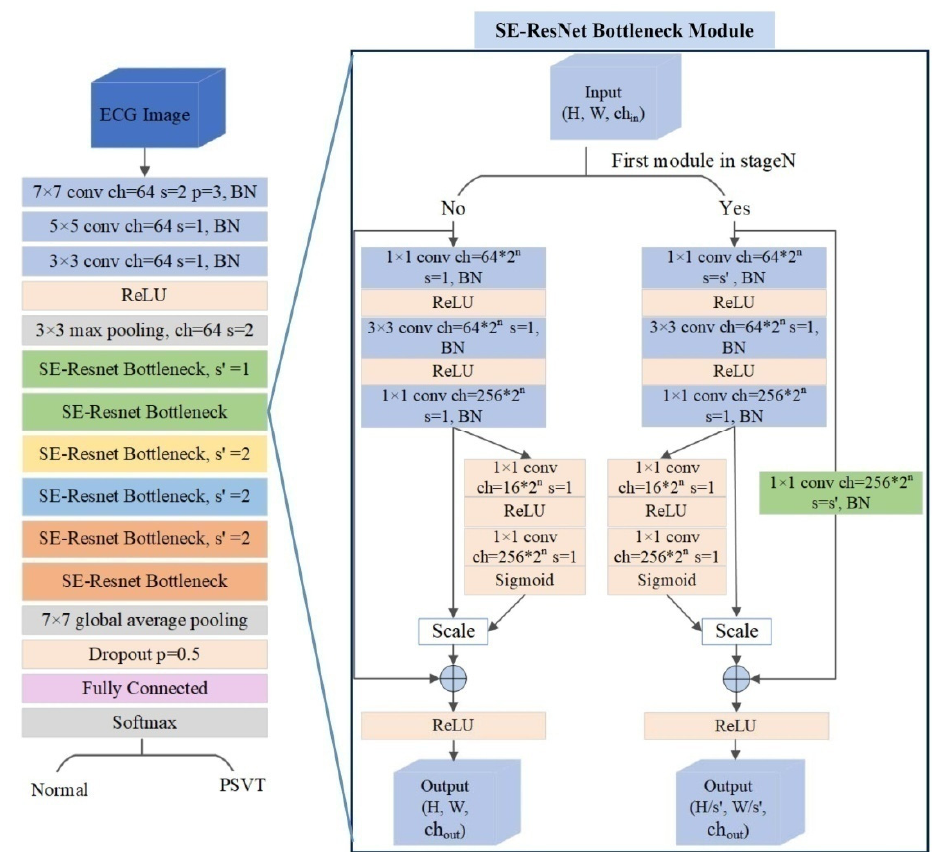
Figure 3. The architecture of the artificial intelligence model. The SE–ResNet Bottleneck contained 4 stages (State N: Stage 0, green; Stage 1, yellow; Stage 2, blue; and Stage 3, orange). Stage 0 and Stage 3 had two SE–ResNet Bottleneck modules each, and Stage 1 and Stage 2 had only one SE–ResNet Bottleneck module each. The value of N ranged from 0 to 3, which also determined the number of channels per module.